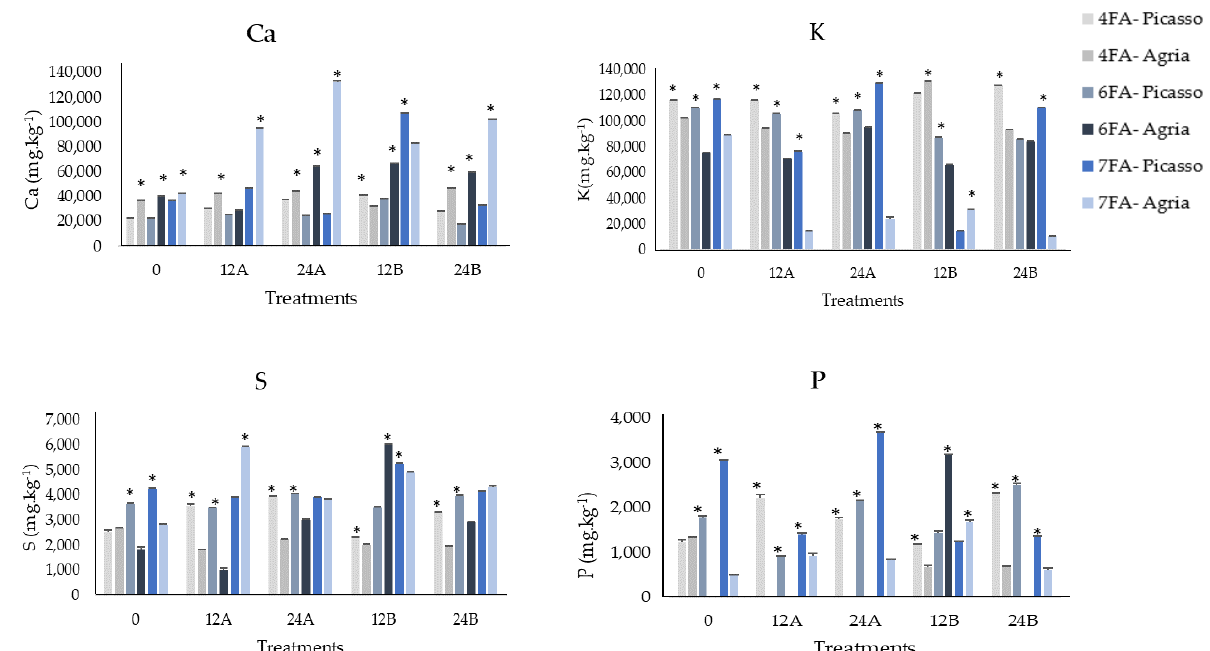
Figure 6. Chemical elements in stems of S. tuberosum L. Agria and Picasso varieties, during the production cycle of plants, after the fourth, sixth, and seventh foliar applications with CaCl 2 and Ca(EDTA). Foliar spray was carried out with two concentrations of CaCl 2 (12 (corresponding to 12A) and 24 (corresponding to 12B) kg · ha − 1 ) and two concentrations of Ca-EDTA (12 (corresponding to 12B) and 24 (corresponding to 24B) kg · ha − 1 ). The control was not sprayed at any time and corresponds to “0”. Chemical quantification was carried out after the fourth (corresponding to 4FA), sixth (corresponding to 6FA), and seventh (corresponding to 7FA) foliar applications. Mean values ± S.E. ( n = 4) and significantly higher content between varieties within each treatment after the 4FA, 6FA, and 7FA are identified (*). Values not shown in P are below the detection limit of the device (450 mg · kg − 1 ).